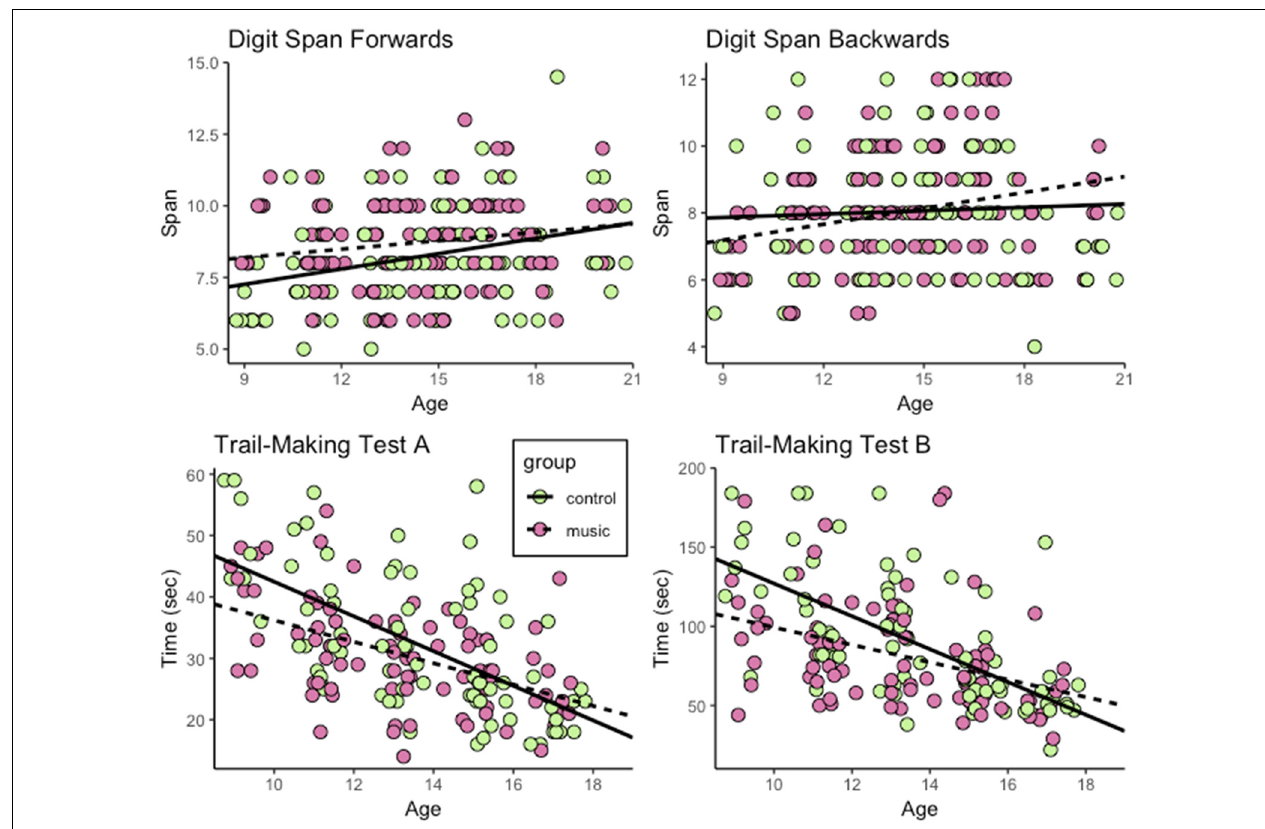
FIGURE 1 | Performance of participants in the Digit Span forwards and backwards, and the Trail-Making A and B tests across all age groups. Music and Control groups represented with different colors.